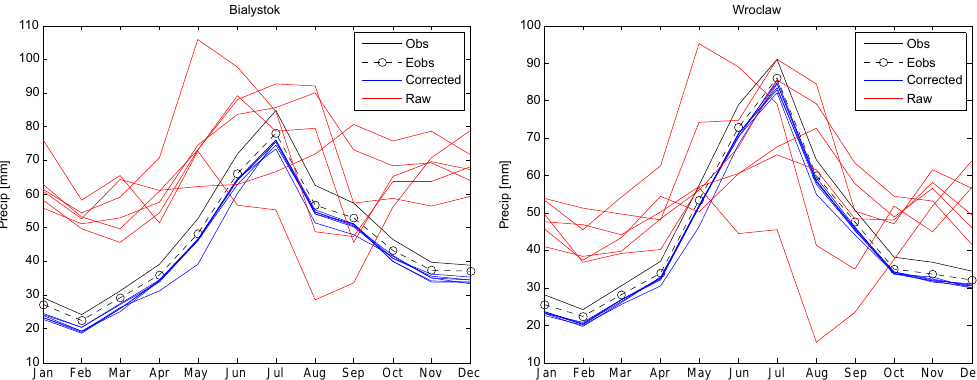
Figure 2. Comparison of mean monthly sums of precipitation calculated over the reference time period for two grid cells located close to Białystok (NE Poland) and Wrocław (SW Poland). Black continuous lines denote observations from meteorological stations, dashed lines denote observations from E-OBS reanalysis grid cells, red lines denote uncorrected precipitation series from the RCMs, and blue lines denote the bias corrected precipitation